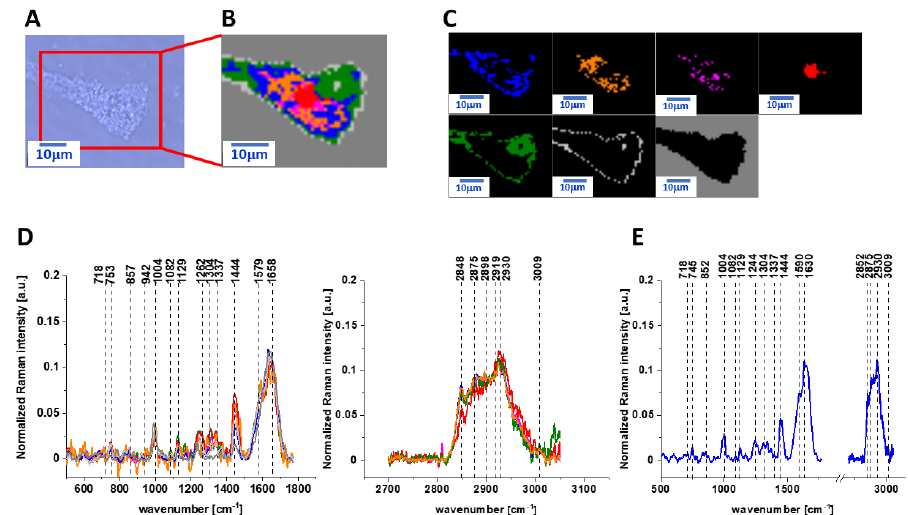
Figure 4. The microscopy image ( A ), Raman image ( B ) of human colon normal single cell CCD-18 Co under oxidative stress conditions generated by using tBuOOH for incubation time of 24 h and concentration of 50 µM in medium constructed based on cluster analysis (CA) method; Raman images of all clusters identified by CA assigned to lipid-rich regions (blue and orange), mitochondria (magenta), nucleus (red), cytoplasm (green), cell membrane (light grey), and cell environment (dark grey) ( C ); the average Raman spectra typical for CCD-18 Co human normal colon cell for all identified clusters for low frequency and high frequency region ( D ), and the average Raman spectrum for human normal colon cells - for cells as a whole ( E ), cells measured in PBS, colors of the spectra correspond to the colors of clusters; excitation laser line 532 nm; number of cells=6.